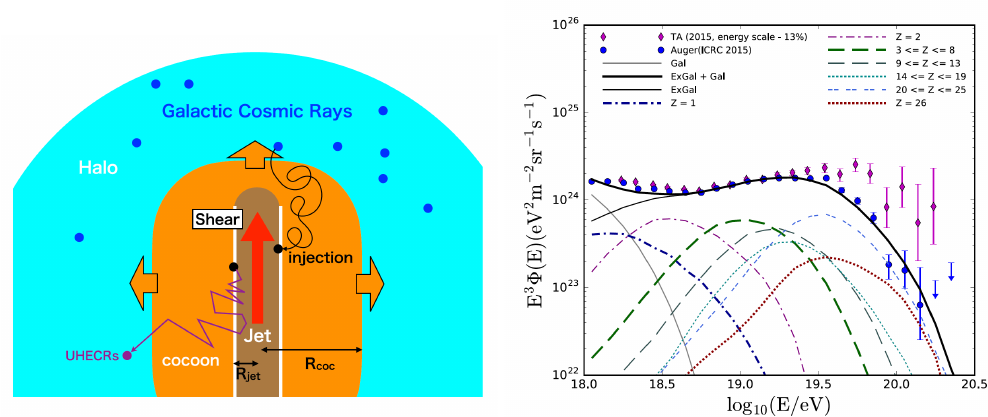
Figure 9. Left: Cartoon of the considered scenario assuming a recycling of galactic cosmic rays by non-gradual shear acceleration in a jet - (turbulent) cocoon system. Some fraction of galactic cosmic rays are considered to be swept up by the kiloparsec-scale jet and reaccelerated to high energies. The return probability of a particle here is dominated by the scattering (turbulence) properties (i.e., particle mean free path) in the cocoon and not in the jet. Right: Reconstruction of the observed UHECR spectrum assuming mildly relativistic ( Γ j (cid:39) 1.4), non-gradual shear acceleration in an extragalactic jet-cocoon system with a thin transition layer ∆ r = 5 pc ( B j = 0.3mG, r j = 0.5 kpc). The composition at the highest end is dominated by intermediate and heavy nuclei. From Ref.